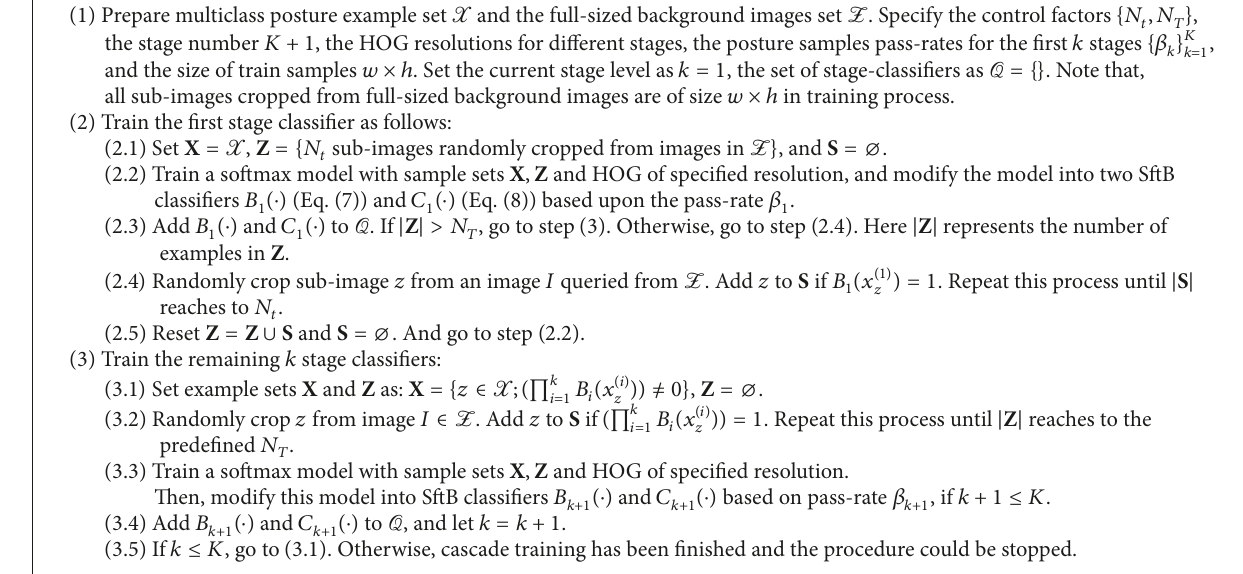
Algorithm 1: The procedure of training softmax-based